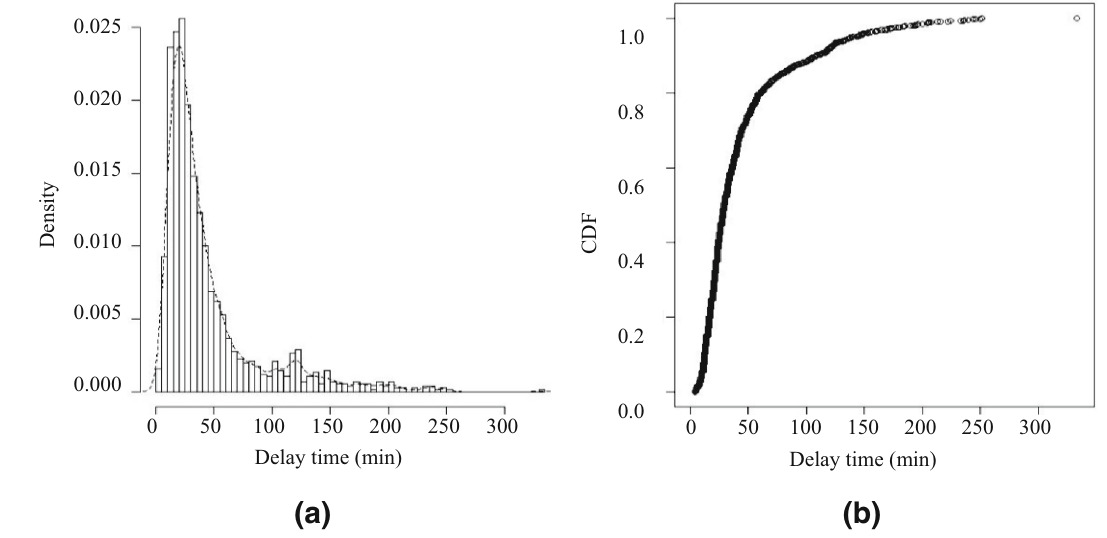
Fig. 4 Histogram ( a ) and cumulative distribution function ( b ) plots of bad